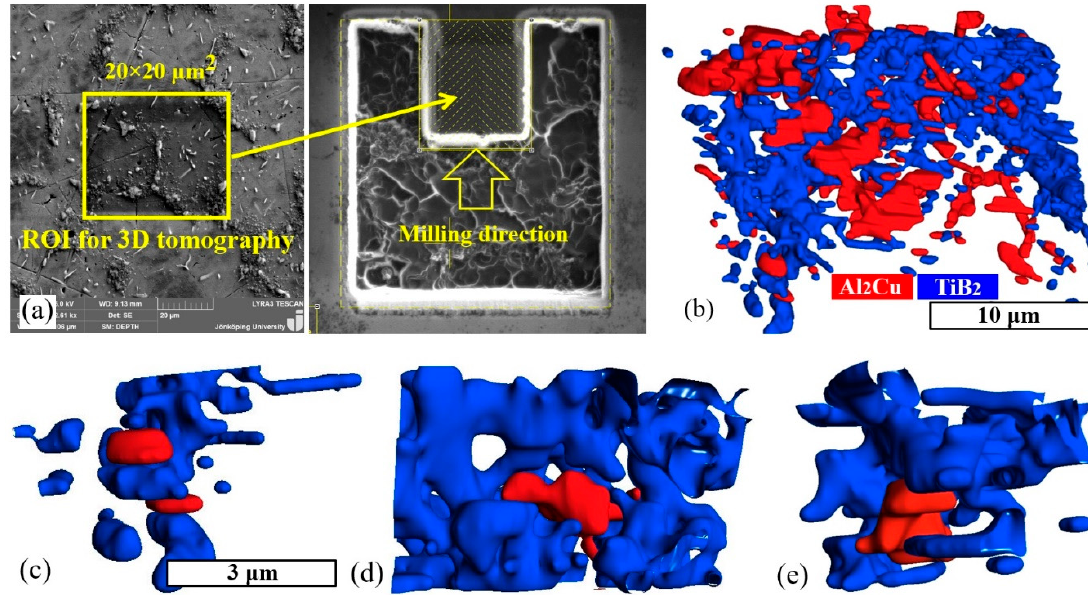
Figure 4. ( a ) Scanning electron image showing the region of interest (ROI) in the as-cast A205 alloy, obtained by image slicing. ( b ) Three-dimensional (3D) reconstructed Al 2 Cu and TiB 2 particles in the selected bulk from 80 serial-sectioned SEM micrographs. ( c – e ) Expanded local regions in the selected bulk.